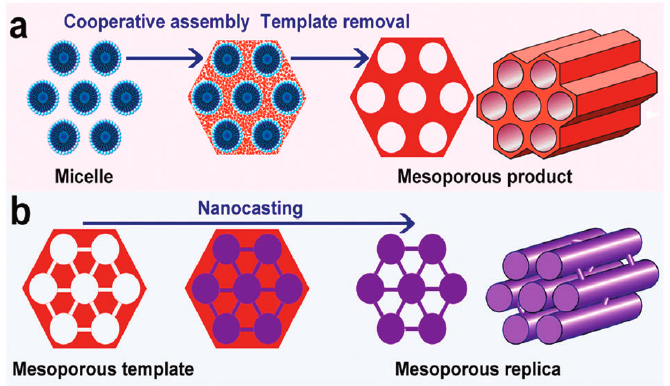
Figure 6. Template method for synthesis of mesoporous materials: ( a ) soft-templating method, ( b ) hard-templating (nanocasting) method. Reproduced from [29] with permission of The Royal Society of Chemistry.